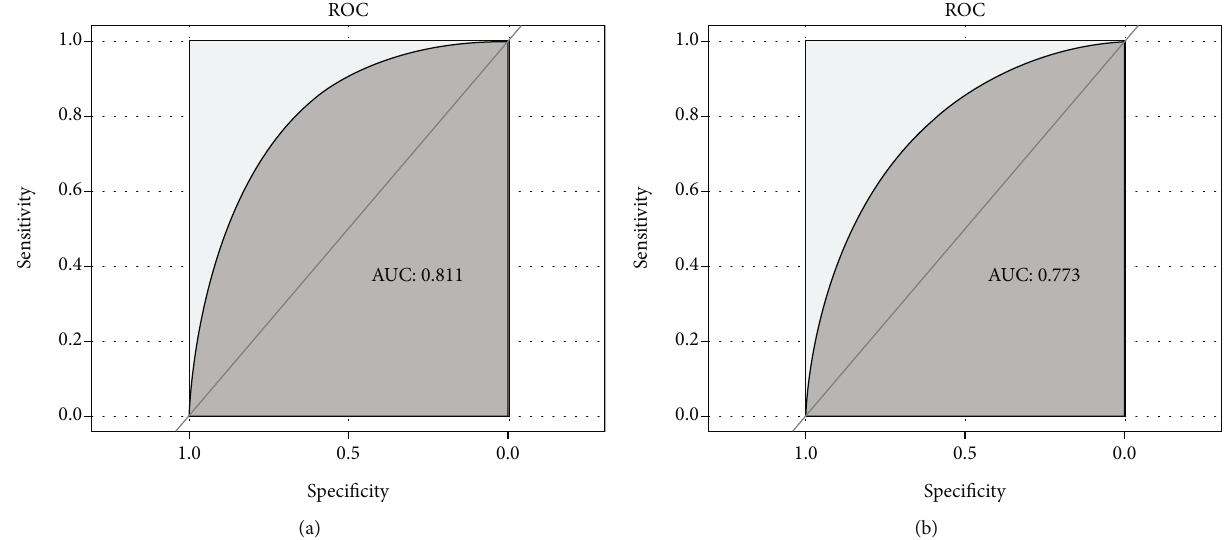
Figure 4: ROC curves of clinical prediction models were drawn based on the data of the training set (a) and validation set (b). Abbreviation: AUC: the area under the receiver operating